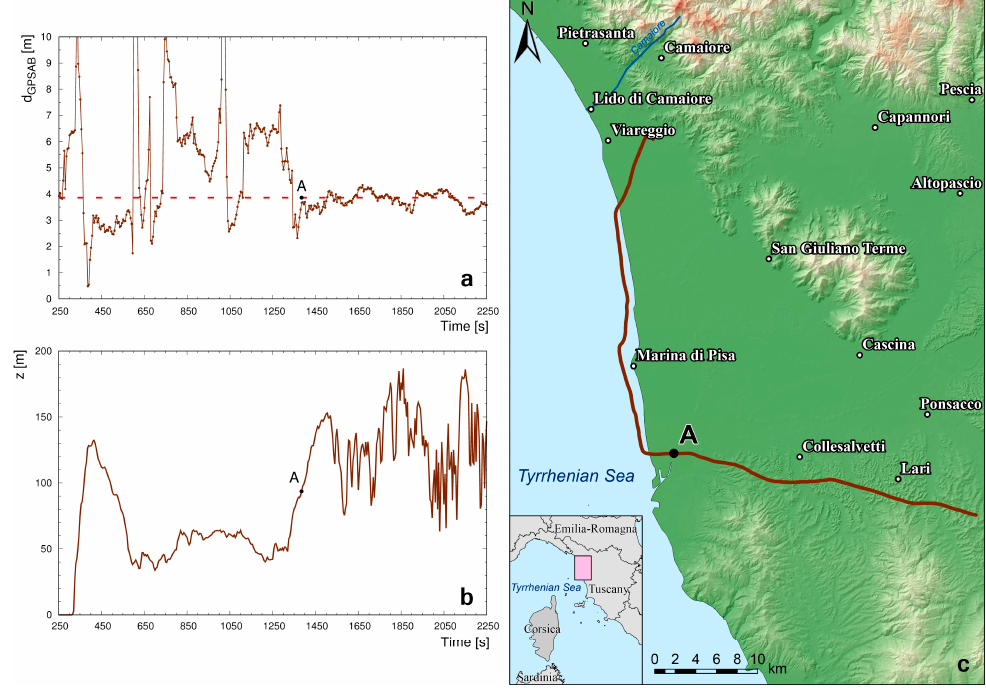
Figure 6. ( a ) Reconstructed distance between GPSA and GPSB as a function of time during a portion of F15. The dashed red line represents the (3.83 ± 0.01) m reference distance and the brown line represents the average reconstructed d GPSAB during the flight. The large fluctuations observed in the reconstructed distance when flying over the sea are strongly reduced when flying over land, in particular when flying more than 3 km far from the coast (point A). ( b ) Mean height above the ground level z(m) (digital elevation model is subtracted) measured by GPSABC. ( c ) Flight path of